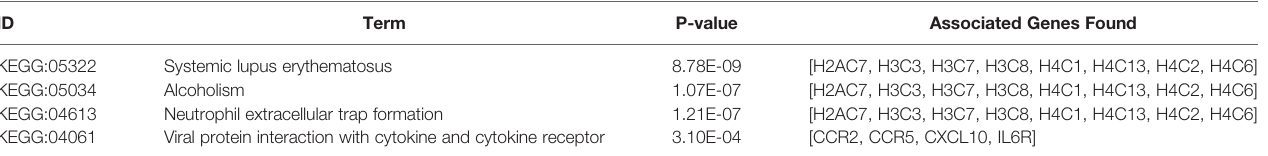
TABLE 4 | KEGG pathways of the 35 characteristic down-regulated genes.